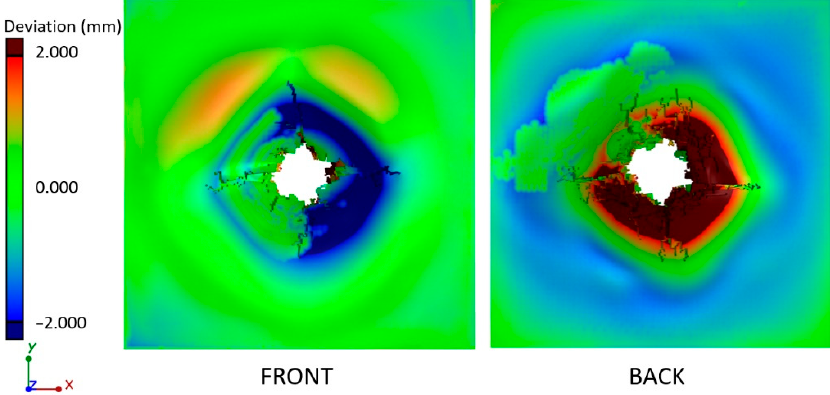
Figure 18. Cross-section of the panel after the projectile has passed: ( a ) simulation result, ( b ) experiment result.